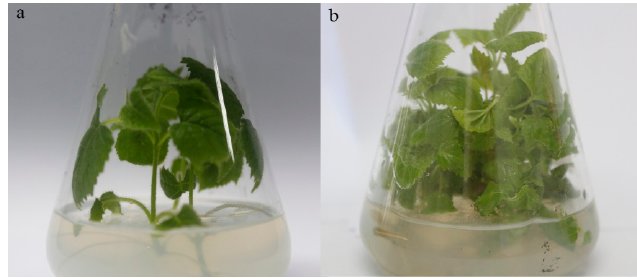
Figure 1. Morphology of healthy and infected plantlets. ( a ) heathy P . fortunei , ( b ) infected P . fortunei .